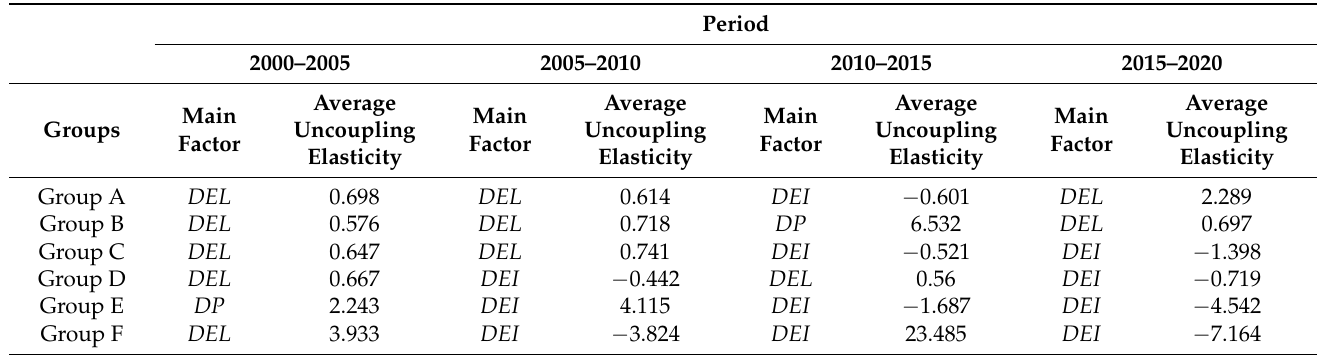
Table 3. Analysis of the main driving factors of each group of urban areas. Period